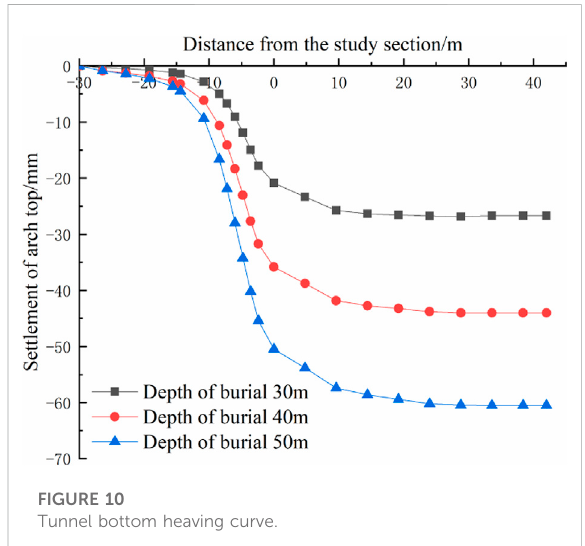
FIGURE 10 Tunnel bottom heaving curve.